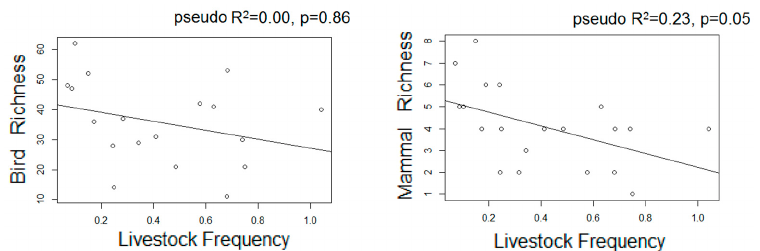
Figure 3. Scatterplots showing associations between bird and mammal richness and land-use proxies.